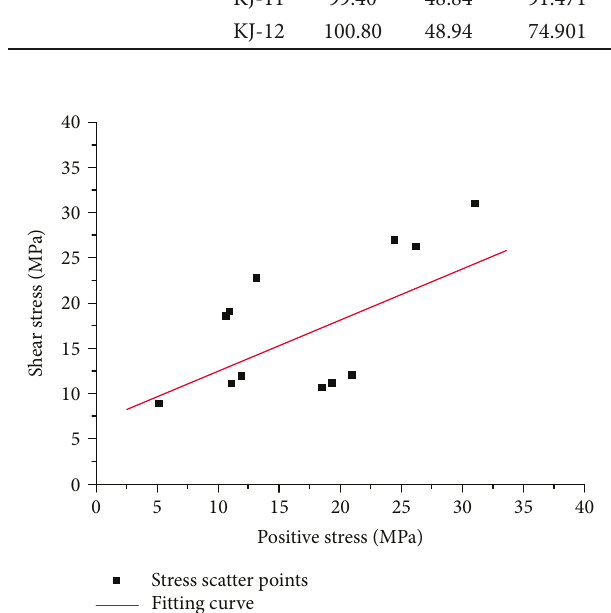
Figure 7: The relationship between the shear stress and the positive stress of the surrounding